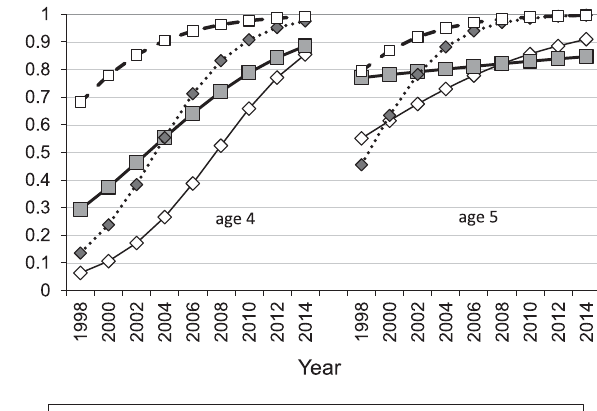
Fig. 3. The predicted proportion of mature female and male anadromous white fi sh ( Coregonus lavaretus ) in relation to the catch year (1998 – 2014) among four- (age 4) and fi ve-year-old (age 5) mature and immature fi sh caught in June – December in the southern (S) and northern (N) Gulf of Bothnia (models, Tab. A.2). Sample sizes for mature and immature fi sh 3479 and 1668 at age 4 and 3260 and 644 at age 5, respectively.